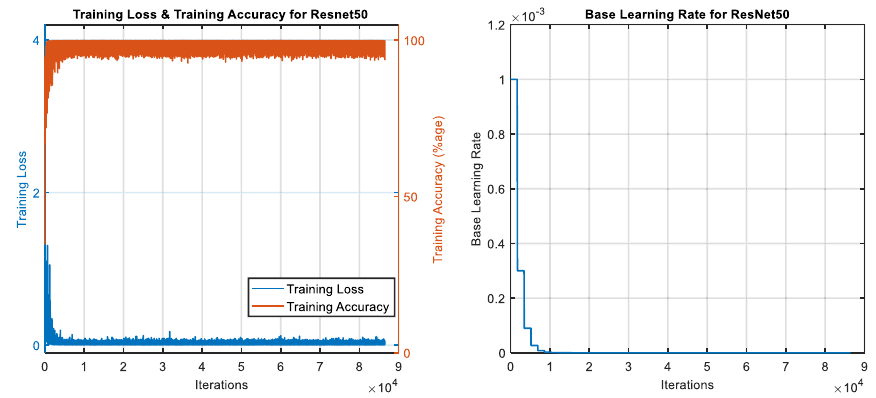
Fig. 9 Plot for training loss, accuracy, and base learning rate for ResNet50